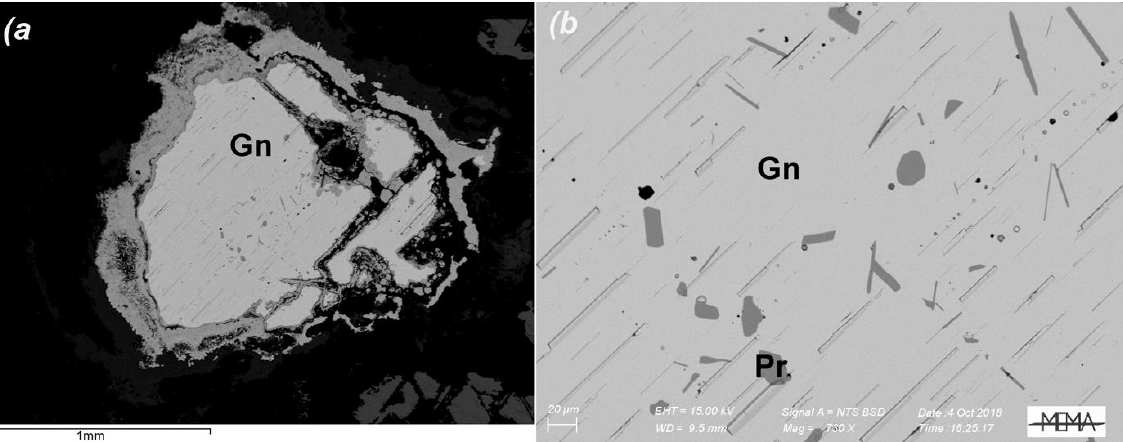
Figure 8. BSE images of ore fragments within mortar from Montieri showing galena ( a ) with proustite-pyrargyrite inclusions, enlarged in ( b )Abbreviations: Gn = galena; Pr = proustite-pyrargyrite.